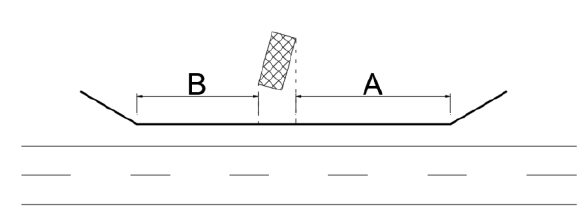
Figure 5 . Minimum length of guardrail in front of (A) and behind (B) protected